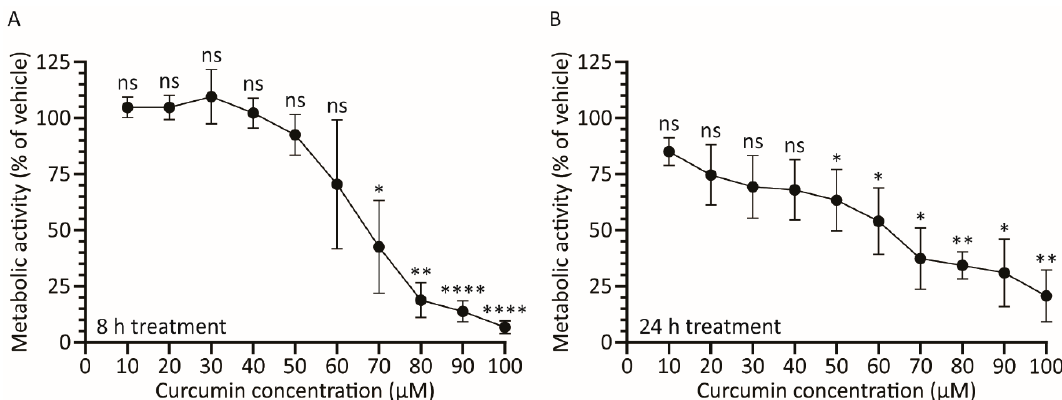
Figure 2. Treatment with curcumin causes a dose-depended decrease in cellular metabolic activity. A549 cells in 96-well plates were incubated with medium containing curcumin from 0–100 µM. Cellular metabolic activity was determined 8 ( A ) or 24 ( B ) h later. The mean of three experiments are shown and the error bars represent standard deviation (SD) of the mean. * p ≤ 0.05, ** p ≤ 0.01, **** p ≤ 0.0001, ns p > 0.05. Microorganisms 2020 , 8 , x FOR PEER REVIEW